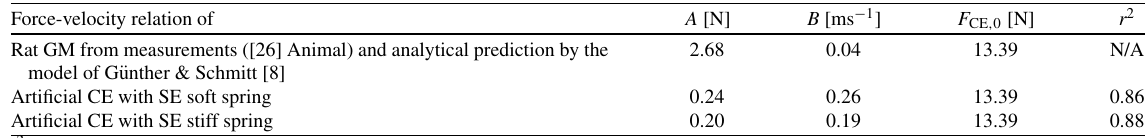
Force-velocity relation